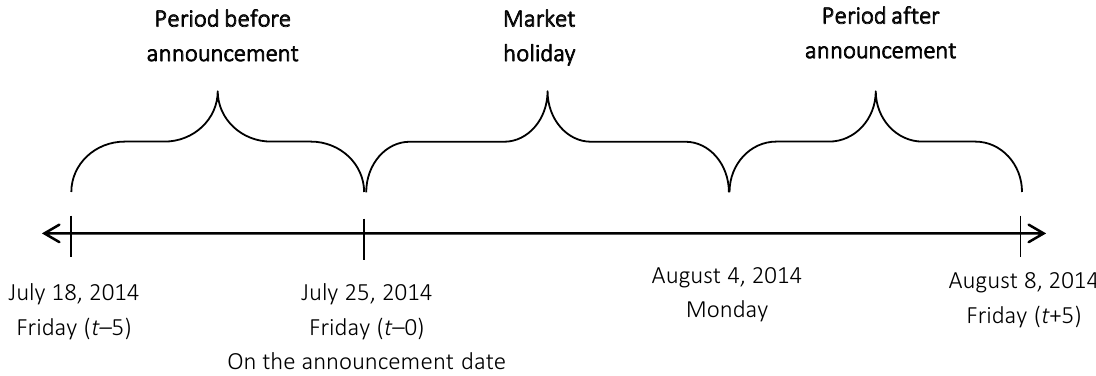
Figure 1. Event study